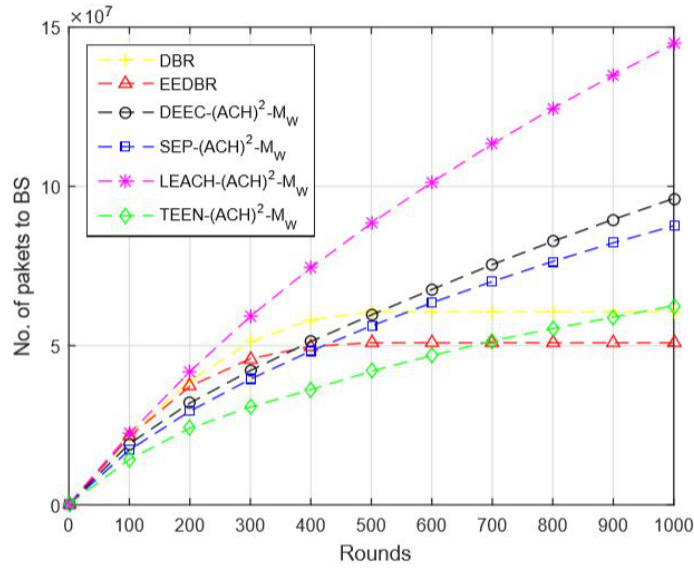
Figure 10. Number of Packets Sent to